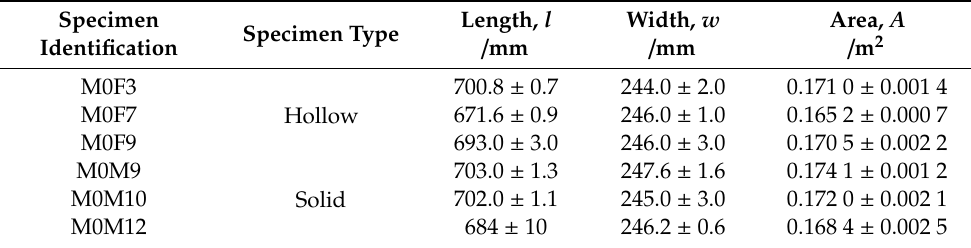
Table A4. Cross-section area measurements in tested masonry